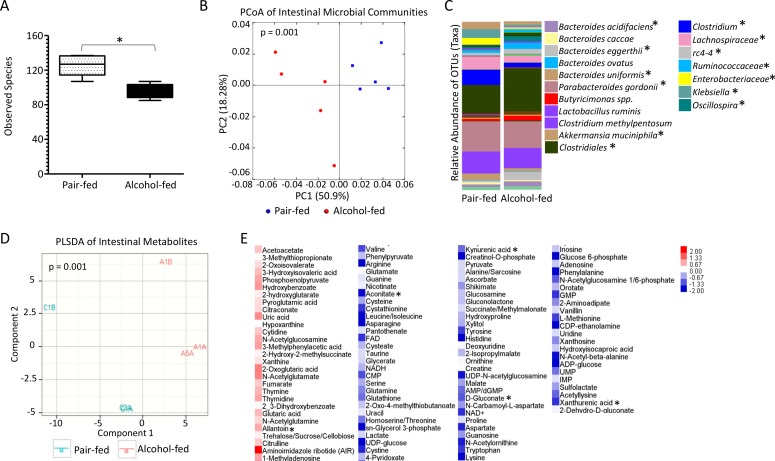
Binge-on-chronic alcohol use alters the intestinal microbial and metabolic profile.(A) Alcohol-treated mice have significantly lower alpha-diversity compared to pair-fed mice as determined by observed species via Qiime. (B) Alcohol-treated mice (red circles) showed significantly different microbial community structures from pair-fed mice (blue circles) as determined by principal coordinate analysis of the weighted UniFrac metric via Qiime. (C) Alcohol-treated mice have altered relative abundance of specific OTUs compared to pair-fed mice. (D) Alcohol-fed (red) mice had significantly different microbial metabolites from pair-fed (blue) mice, as shown by Partial Least Squares Discriminant Analysis. (E) Alcohol-treated mice have altered relative concentration of mirobial metabolites compared to pair-fed mice. *indicates P<0.05, by Mann-Whitney U with both Benjamini-Hochberg and Bonferroni corrections. N = 3-10/group.